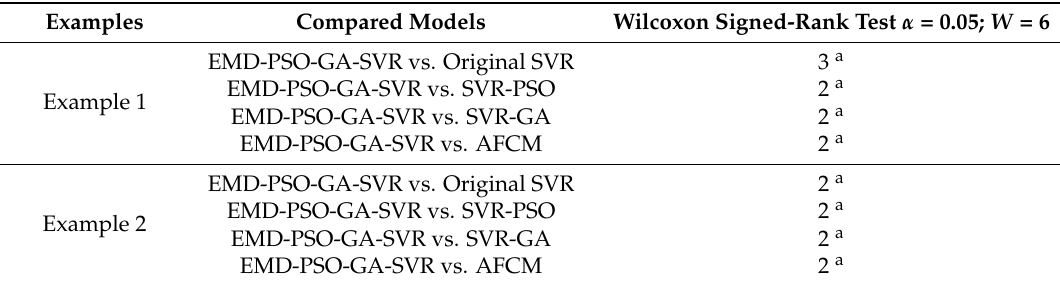
Table 9. Wilcoxon signed-rank